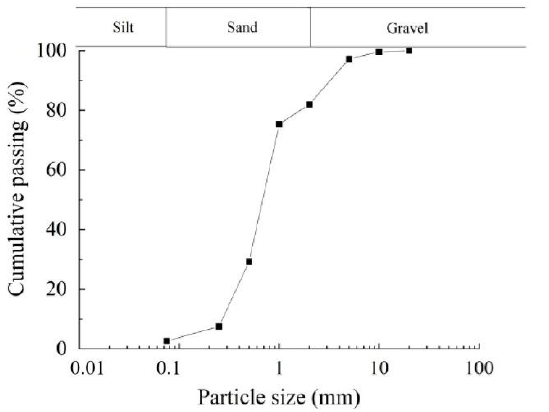
Figure 1. Particle size distribution of sand used in foam concrete .